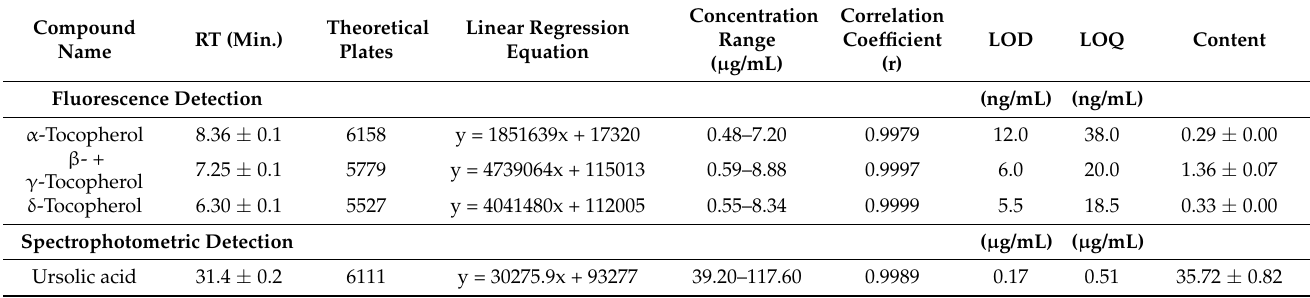
Table 4. Content of selected biologically active compounds (mg/g ± SD) in Eleutherococcus senticosus seed oil ( n = 3) (RT—retention time, LOD—limit of detection, LOQ—limit of quantification. Tocopherol